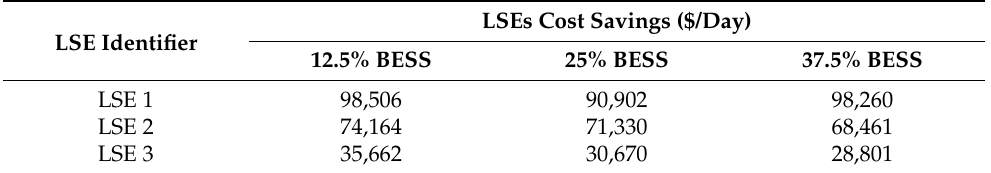
Table 6. Cost Savings of LSEs compared to Base Case.